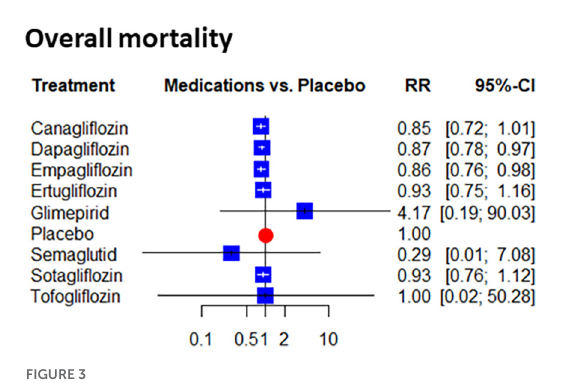
FIGURE3 Network estimates of placebo compared effect on the risk of the overall mortality: Forest plots show the relative risk (RR) values and their 95% confidence intervals of individual treatments as estimated on